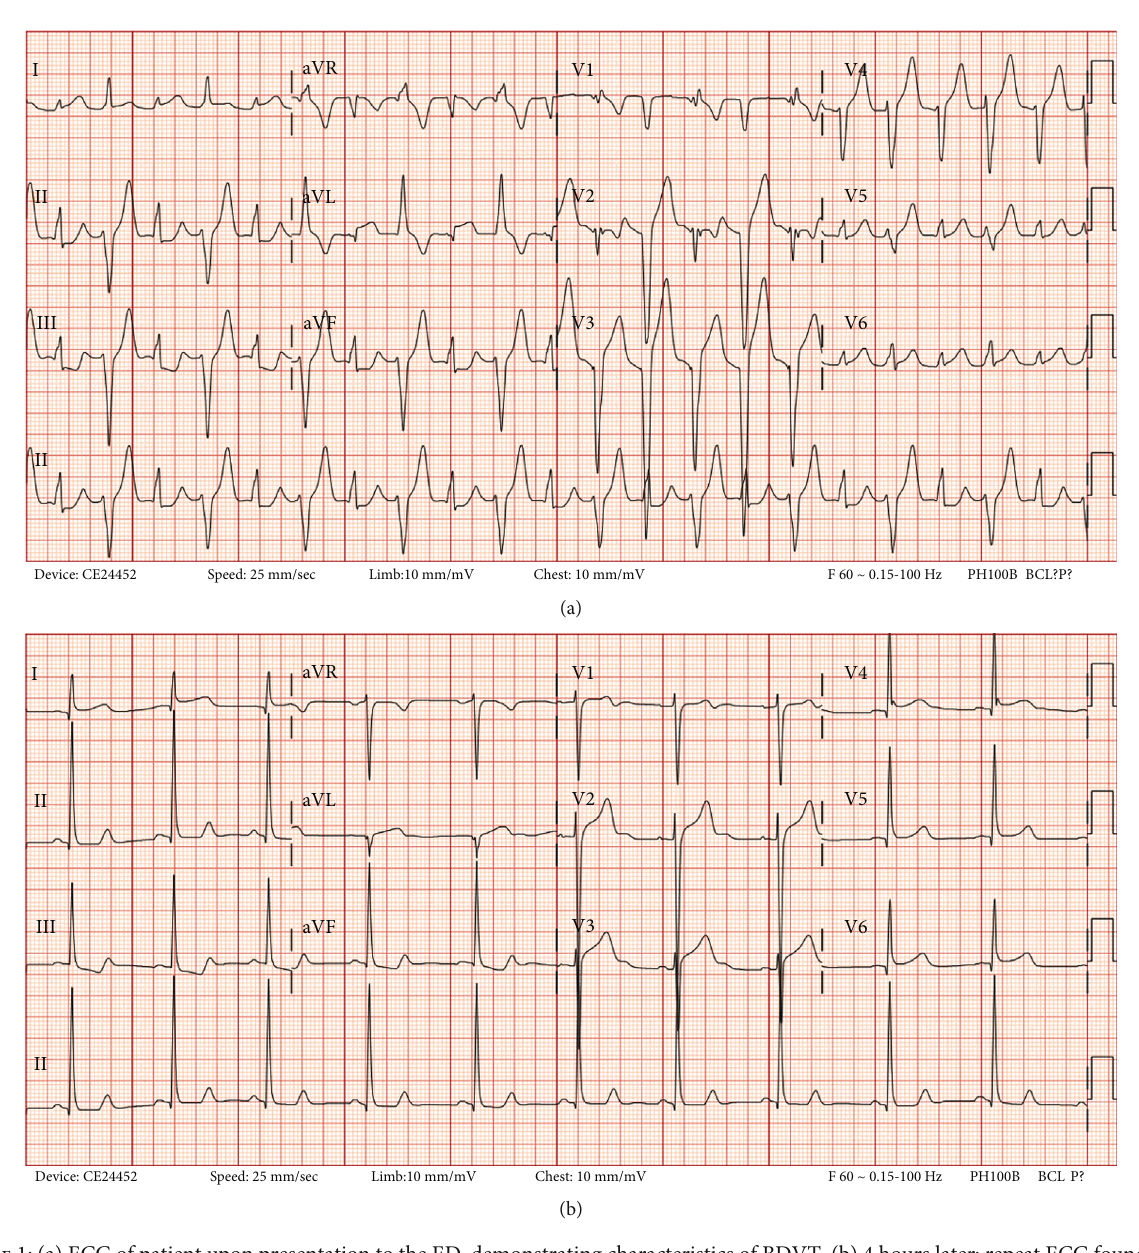
Figure 1: (a) ECG of patient upon presentation to the ED, demonstrating characteristics of BDVT. (b) 4 hours later: repeat ECG found to be